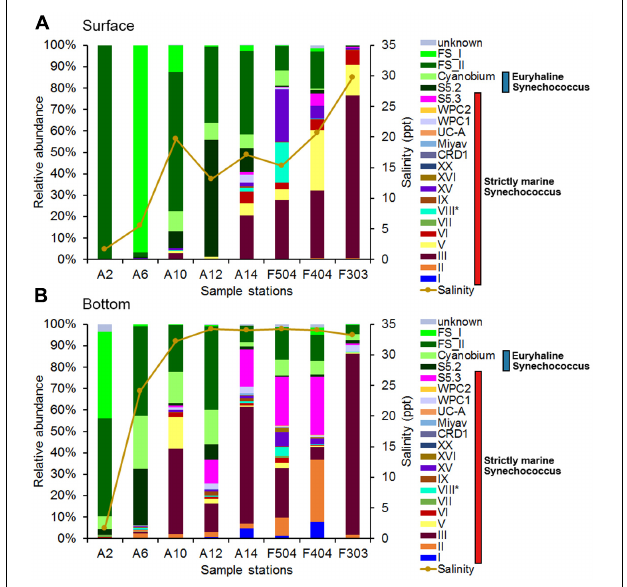
FIGURE 3 | Synechococcus community compositions in the surface (A) and bottom (B) waters based on the rpoC1 gene. FS_I and FS_II are two phylogenetic groups of fresh Synechococcus found in this study (see Supplementary Figure S3). ∗ S5.1 clade VIII: Euryhaline Synechococcus .